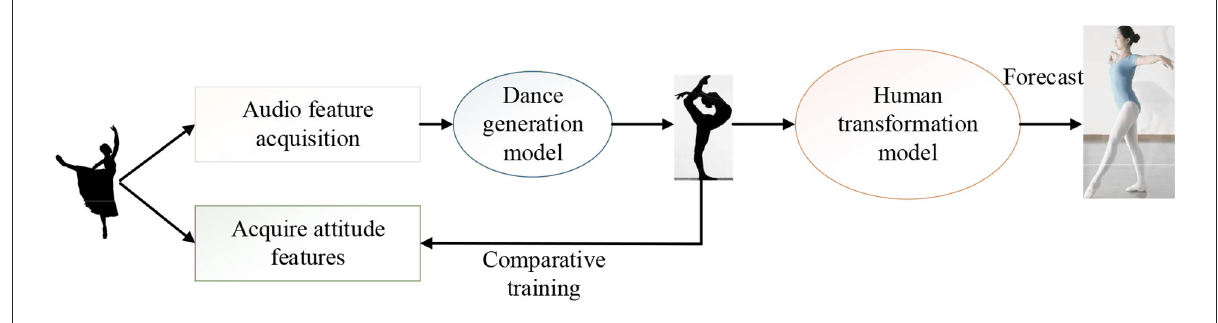
FIGURE6 Experimental process of dance movement